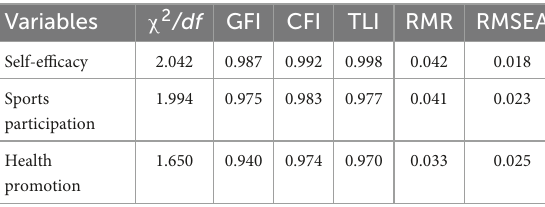
TABLE 2 Fitting indexes of confirmatory factor analysis.